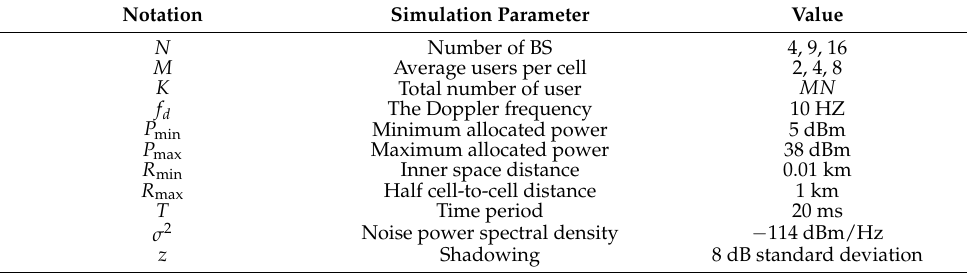
Table 1. Simulation parameters of cellular network.